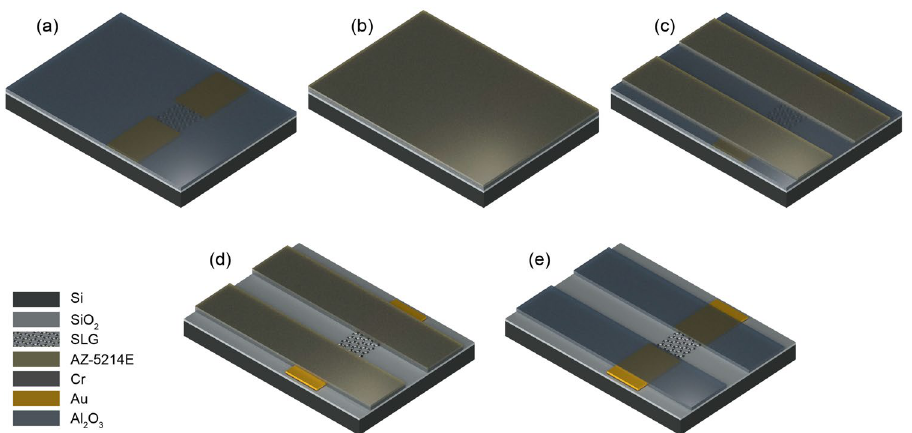
Figure 3. Process flow for the deposition of insulator. ( a ) Uniform Al 2 O 3 film over the sample after ALD. ( b ) Coating of sample with photoresist layer. ( c ) Insulator pattern defined by optical lithography. ( d ) Exposed SLG channel and contacts after wet etching of Al 2 O 3 . ( e ) Patterned Al 2 O 3 film after removal of excess